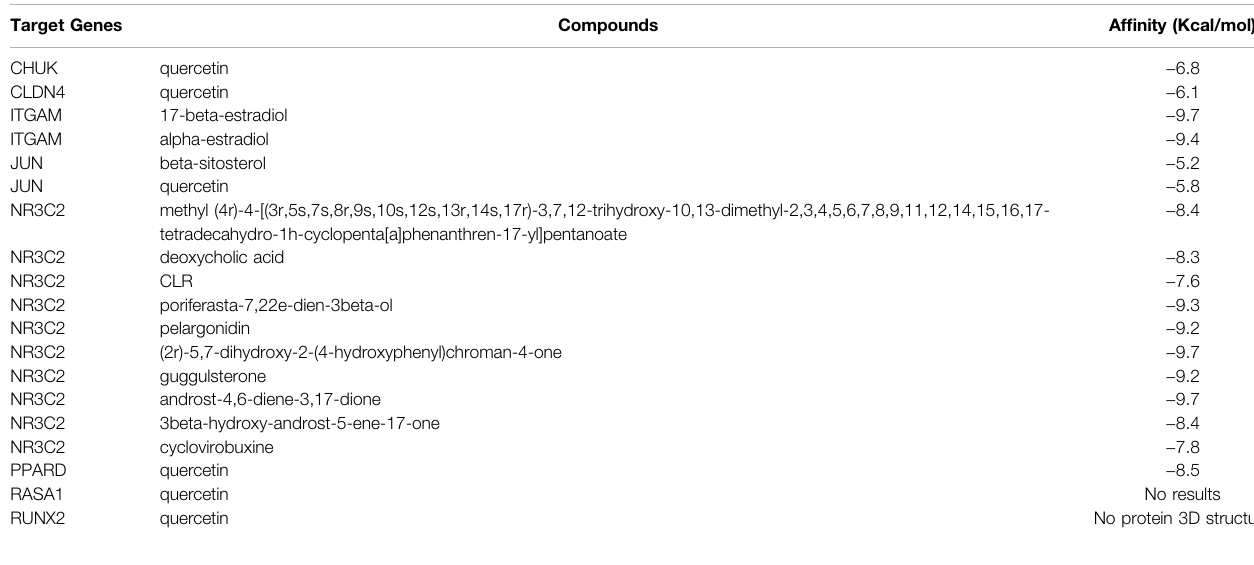
TABLE 2 | The result of molecular